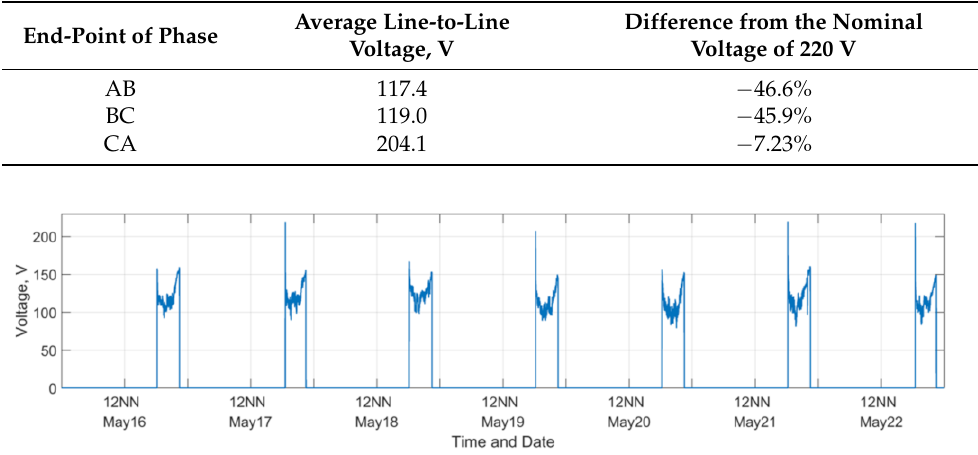
Figure 7. Voltage of a household near the end-point of phase BC as supplied by the village diesel generator for one week in May